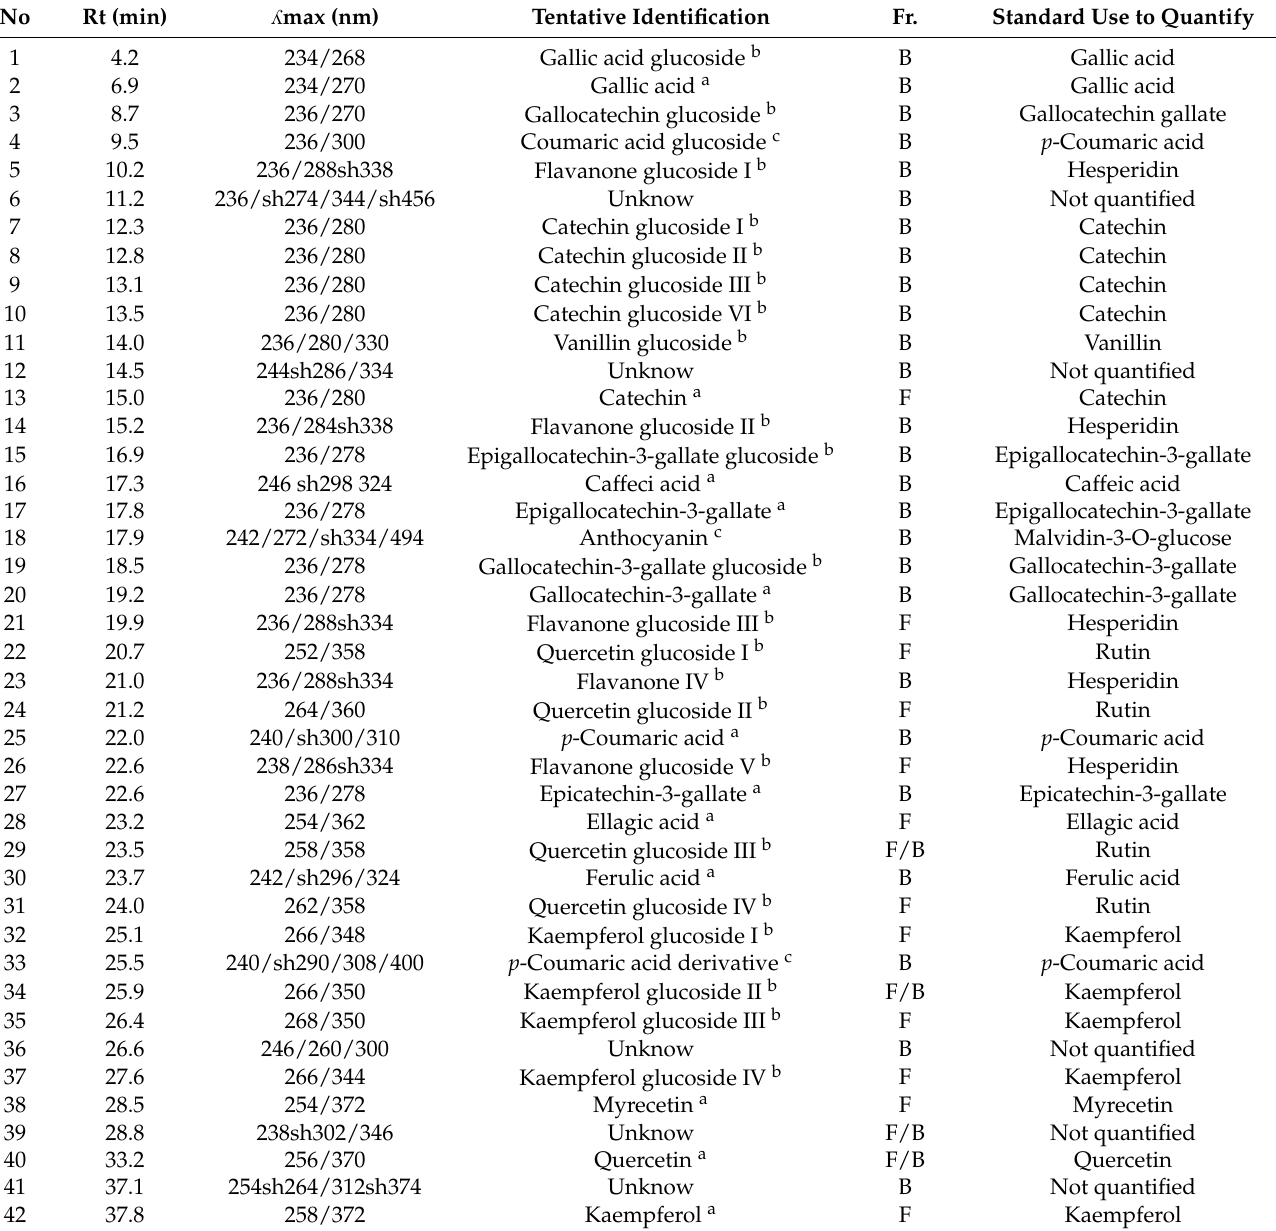
Table 1. Specification to polyphenol compounds detected in persimmon flour obtained from juice coproducts (Rojo Brillante